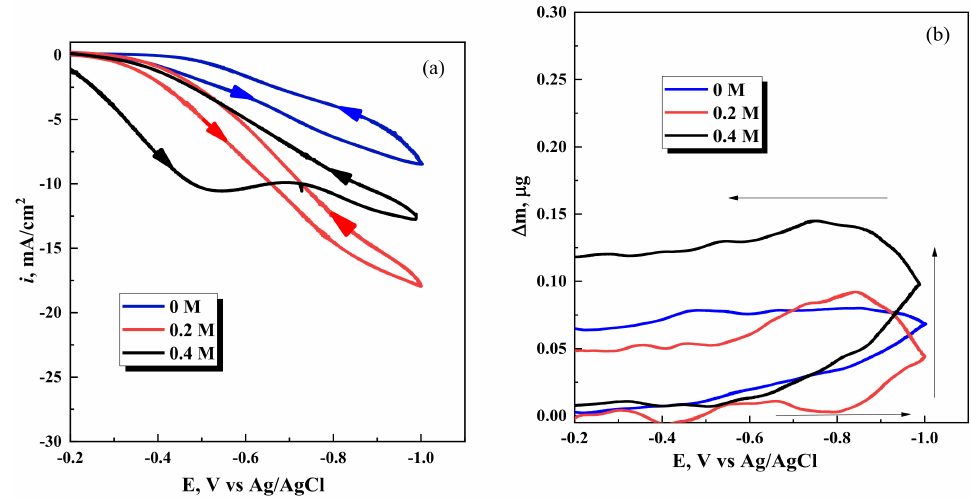
Figure 2. Effects of Na 2 WO 4 concentrations in the solution on ( a ) cyclic voltammograms scans, and ( b ) microgravimetry scans on the Pt electrode. Potential scan rate 20 mV/s; arrows indicate the direction of potential